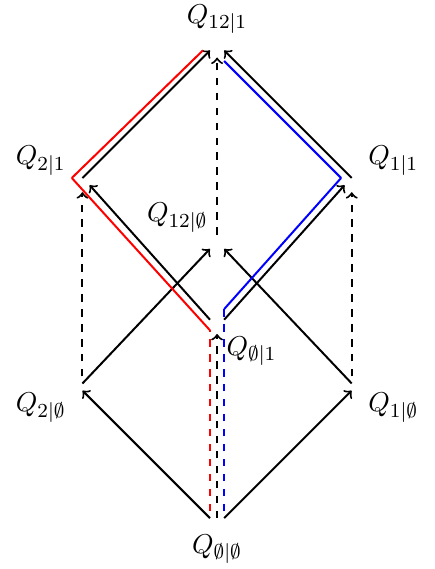
Figure 3 . The QQ-relation (4.19) encodes the change of path from blue to red on the Hasse